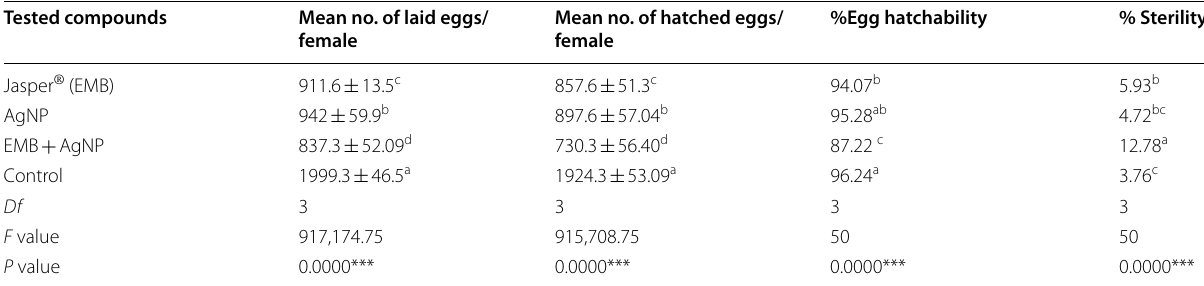
AgNP on fecundity and fertility of the fourth instars larvae of S. littoralis +